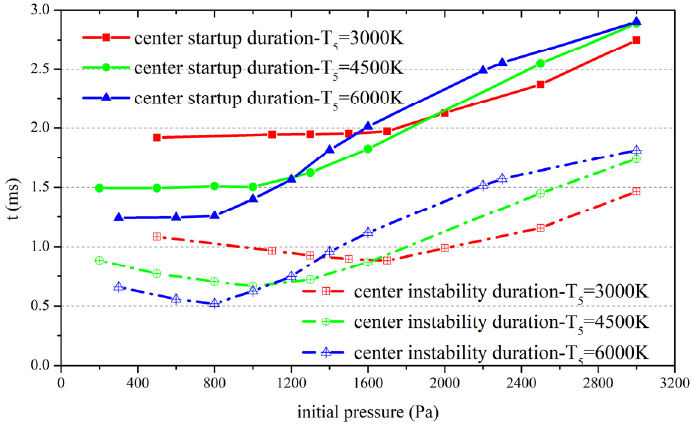
Figure 13. The center startup time and instability time of the nozzle variation with the initial pres- sure ( P 5 = 15 MPa). ( P 5 = 15